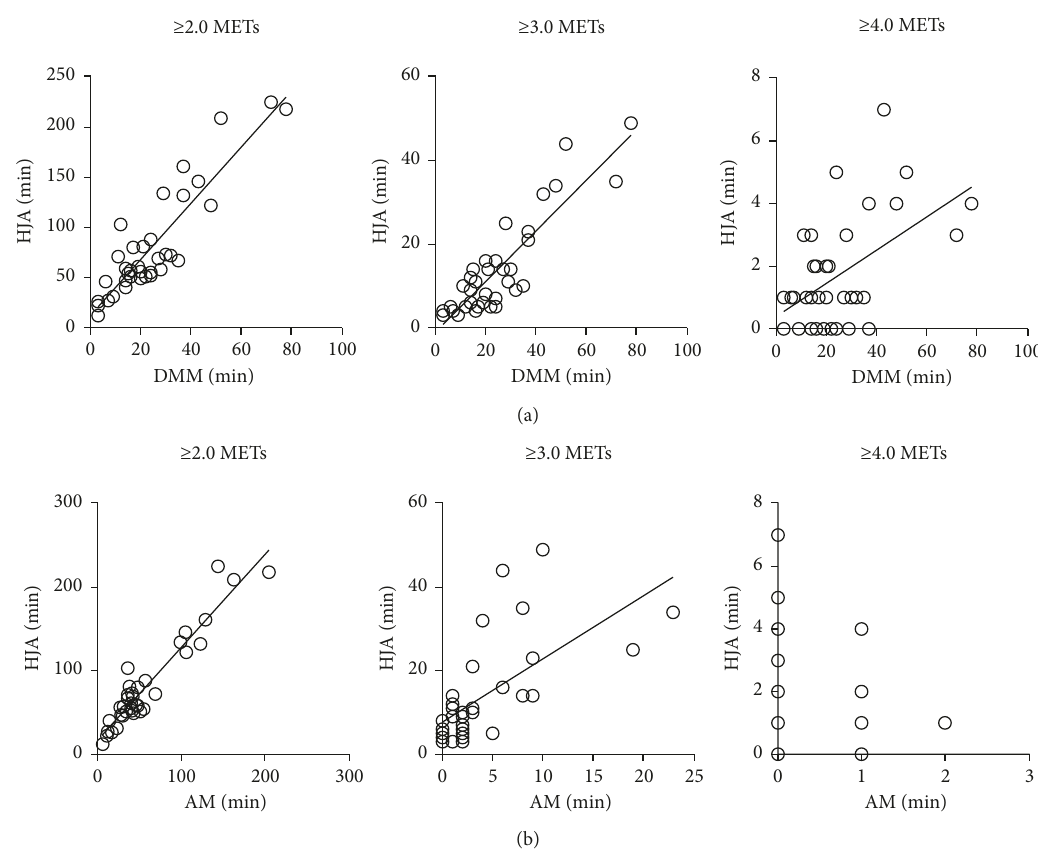
Figure 1: Correlations between the durations of PA measured by HJA and those by DMM and AM. (a) Comparison between HJA and DMM; (b) comparison between HJA and AM. The variables measured by HJA and AM were the duration of PA at ≥ 2.0 METs, ≥ 3.0 METs, or ≥ 4.0 METs. The variables measured by DMM were the duration of locomotion. METs: metabolic equivalents; HJA: Active Style Pro